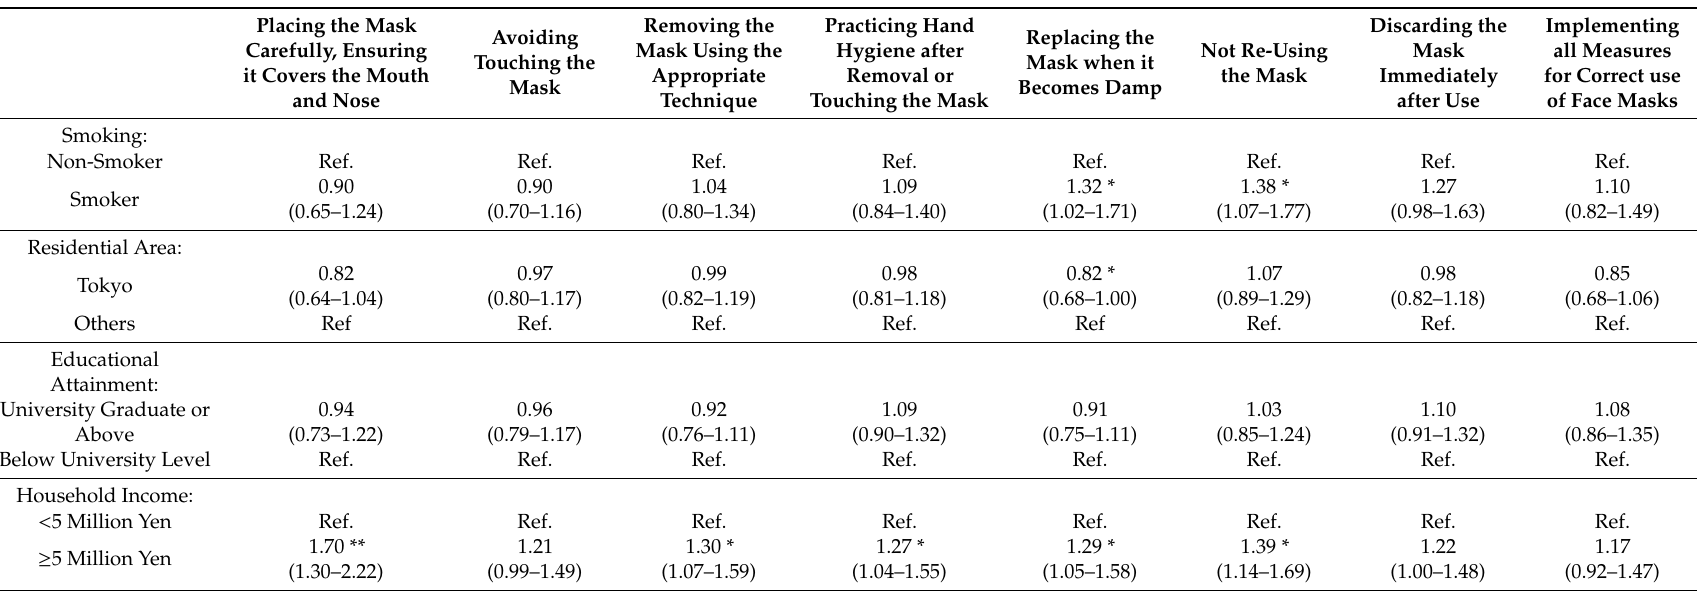
Implementing all Measures for Correct use of Face